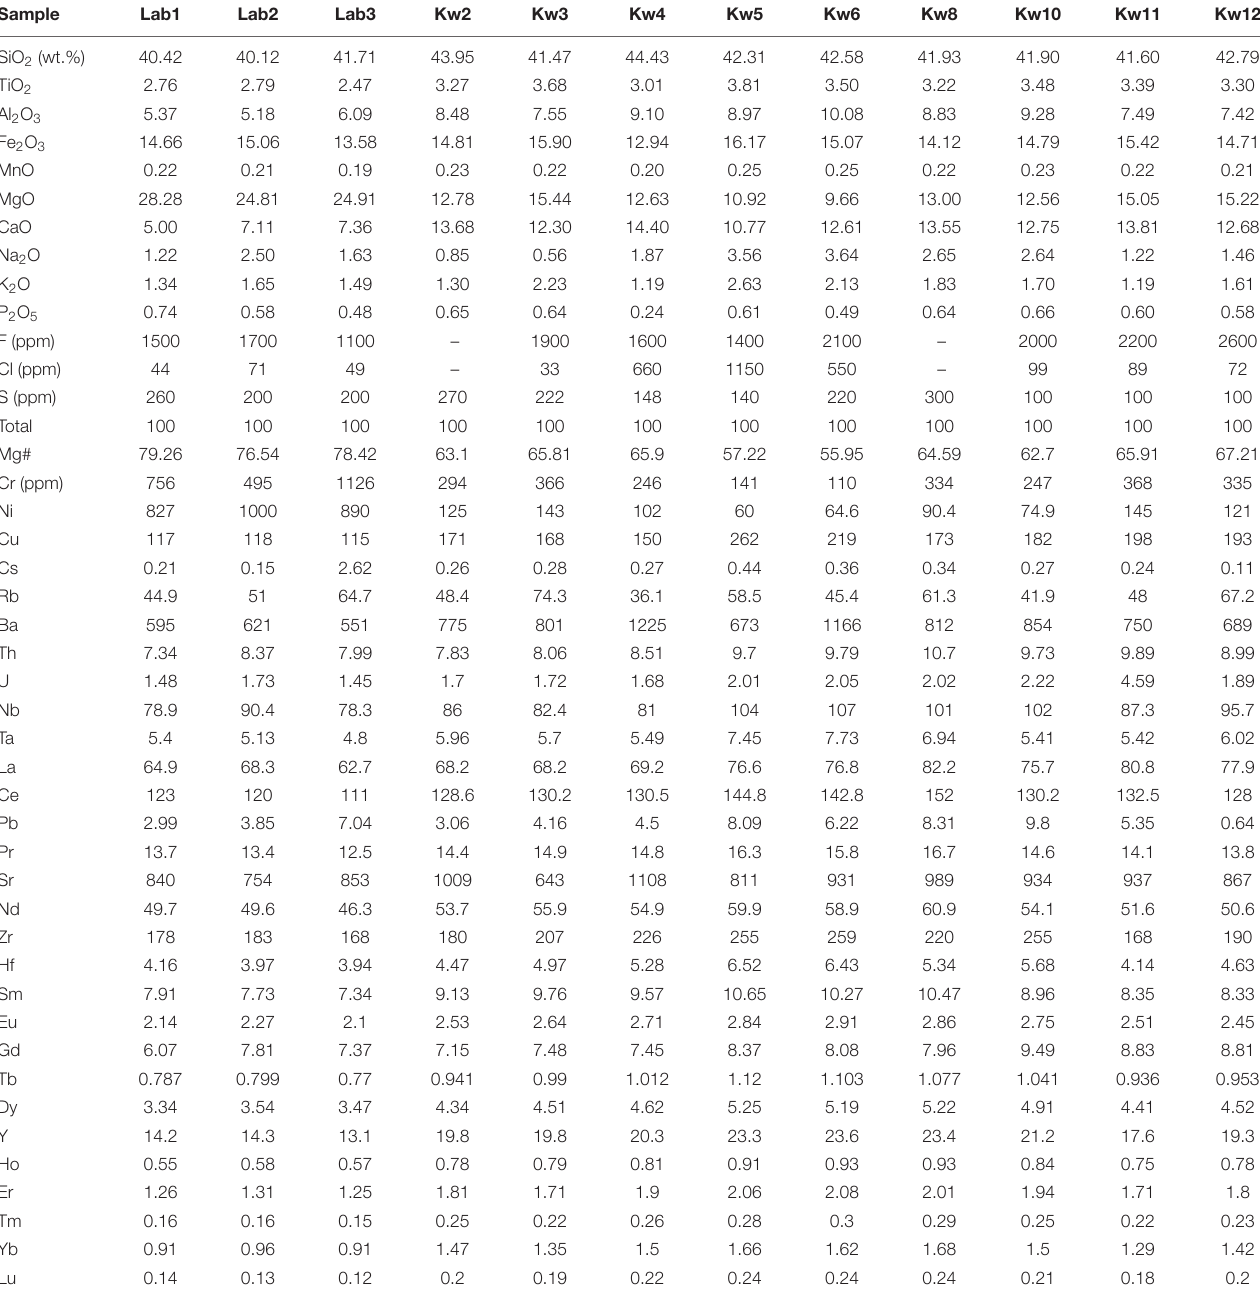
TABLE 1 | Major, volatile and trace element concentrations of the nephelinitic lavas.